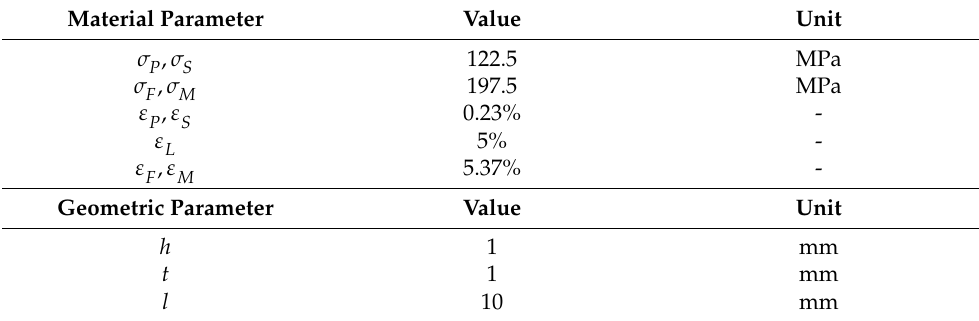
Table 4. Model parameters of the SMA